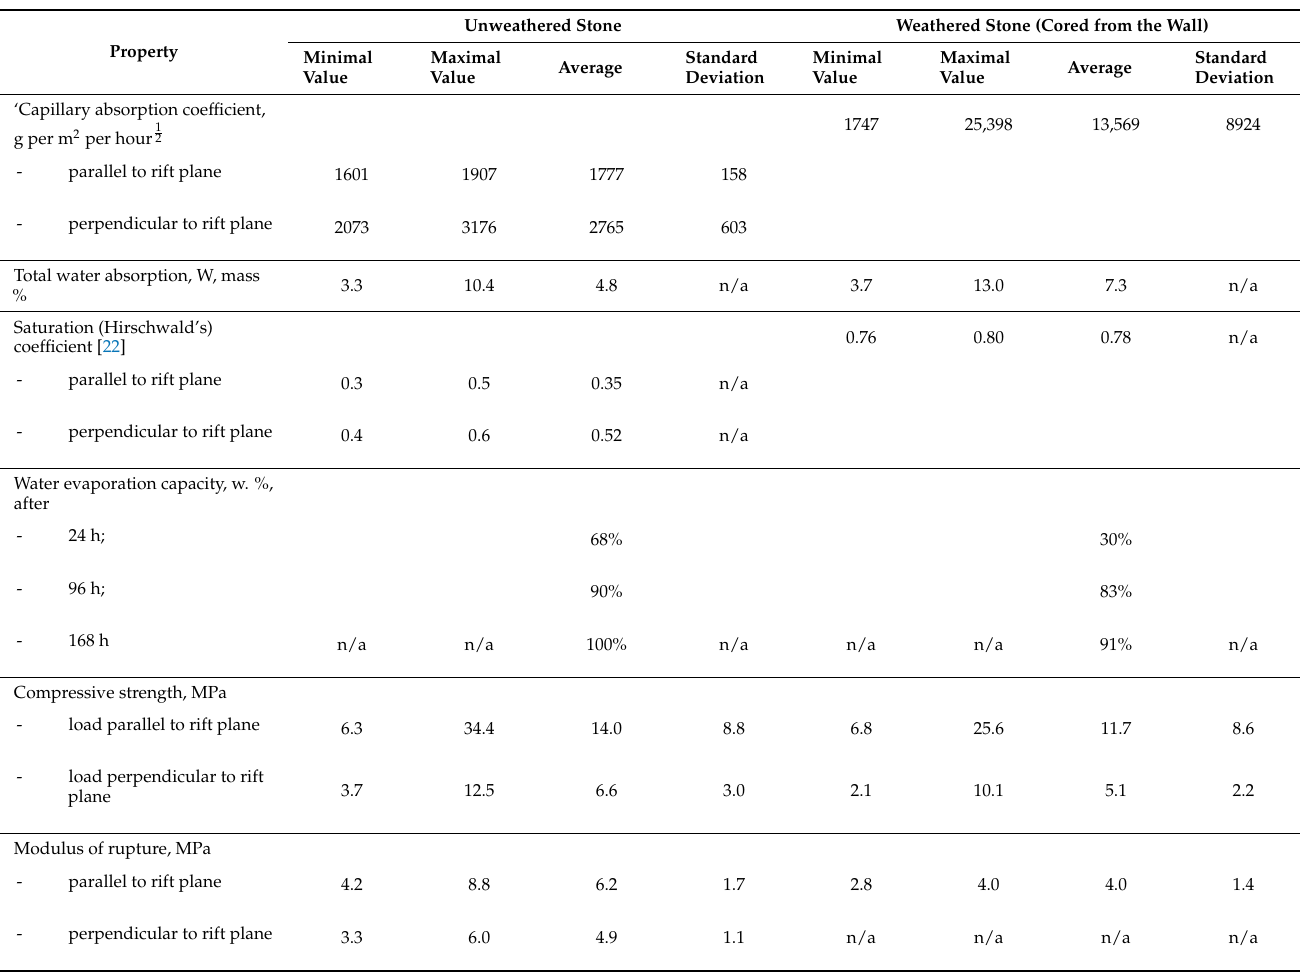
Table 2. Properties of weathered versus unweathered kurkar